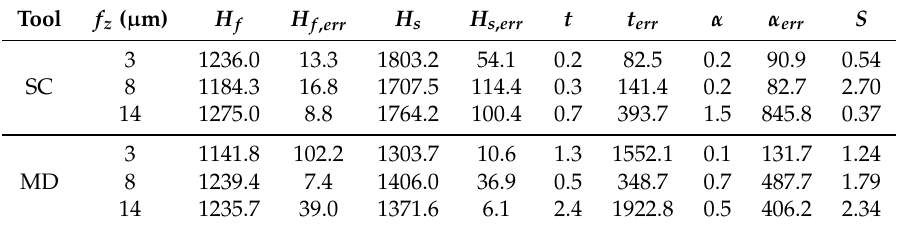
Figure 14. Korsunsky film-substrate-model from Equation (1) [22] fitted to to the averaged ESP-data sets shown in Figure 13. Table 7. Fitted parameters of the Equation (1) fitted to the depth-hardness data from Figure 13, as plotted in Figure 14. The parameters represent the direct output of the plotting software, each with the respective “asymptotic standard error”. For each data set the final sum of squares S is shown